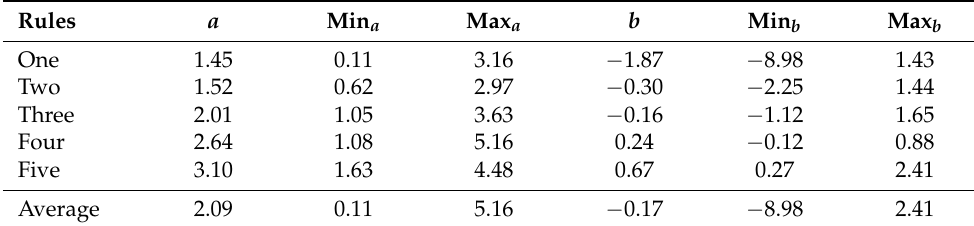
Table 2. Item parameter estimates per rule combination.